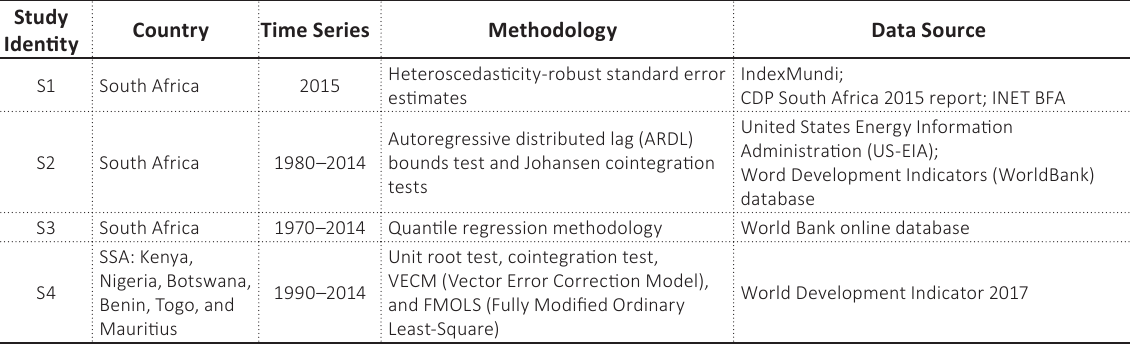
Table 2. Selected papers by country, time series, methodology, and data